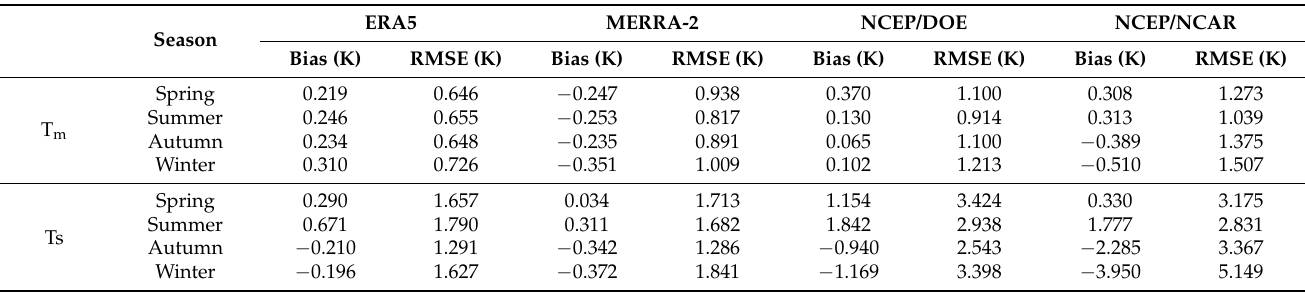
Table 5. Mean bias and RMSE values for T m and Ts derived from four reanalysis data in different